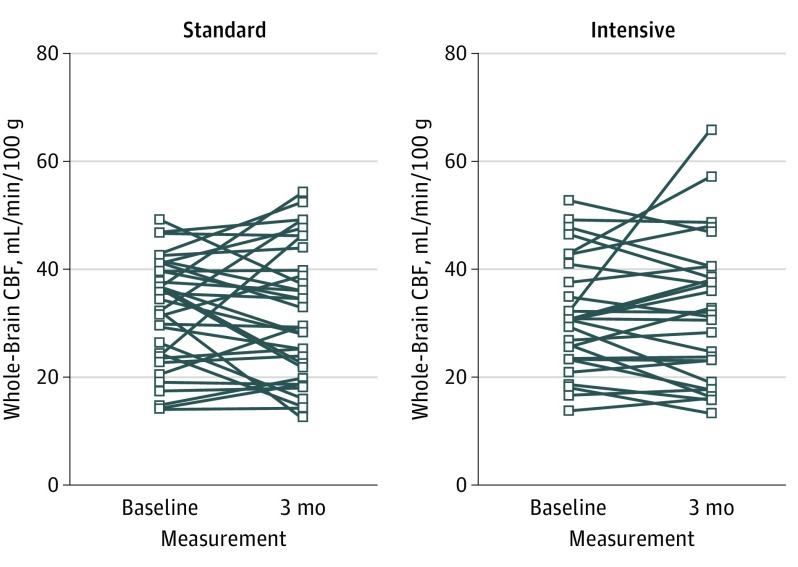
Change in Whole-Brain Cerebral Blood Flow (CBF)The spaghetti plot shows the change for each participant by treatment group.